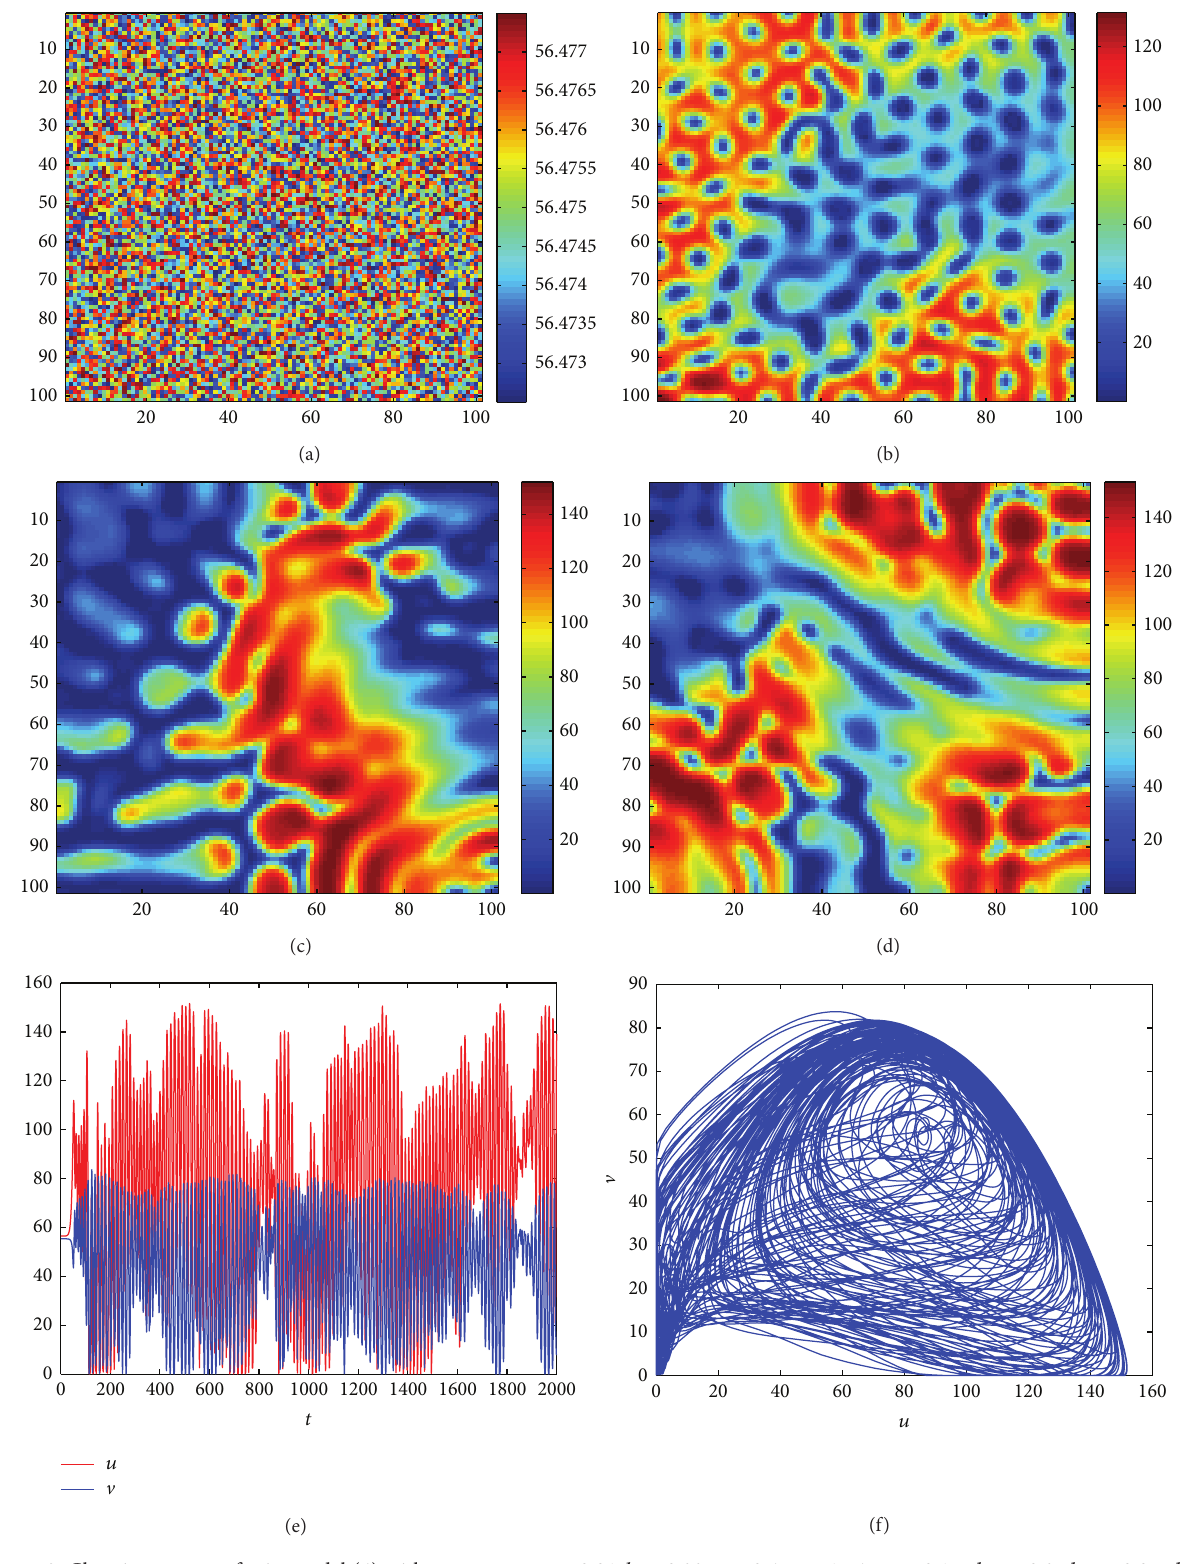
Figure 3: Chaotic patterns of 𝑢 in model (4) with parameters 𝑎 = 0.01 , 𝑏 = 0.22 , 𝑐 = 0.4 , 𝑟 = 1.54 , 𝑚 = 0.17 , 𝑑 11 = 0.2 , 𝑑 12 = 0.05 , 𝑑 21 = = 0.88 , and 𝜏 = 0.46 . Times: (a) 𝑡 = 0 , (b) 𝑡 = 100 , (c) 𝑡 = 1000 , (d) 𝑡 = 2000 , (e) time-series plots, and (f) phase 0.44 , 𝑑 22